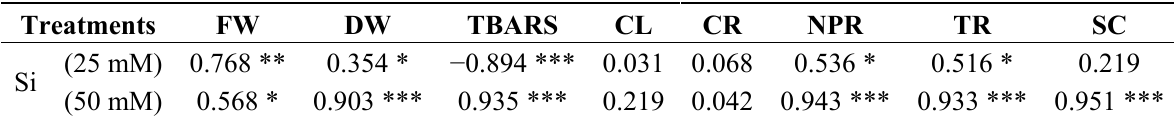
Table 2. Linear correlations among the descriptive parameters with Si concentration. The values measured at 25 and 50 mM after NaCl/Si combined treatment was used for correlation analysis. The correlation coefficient ( r ) and significant differences are